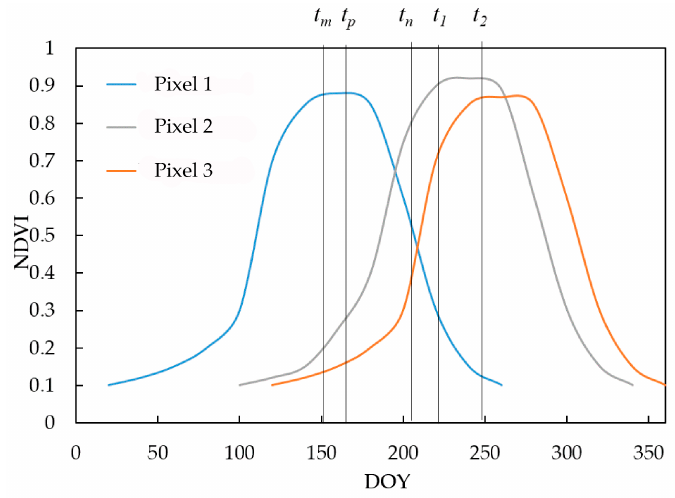
Figure 1. Diagram of simulated Normalized Difference Vegetation Index (NDVI) profiles for different crop pixels.